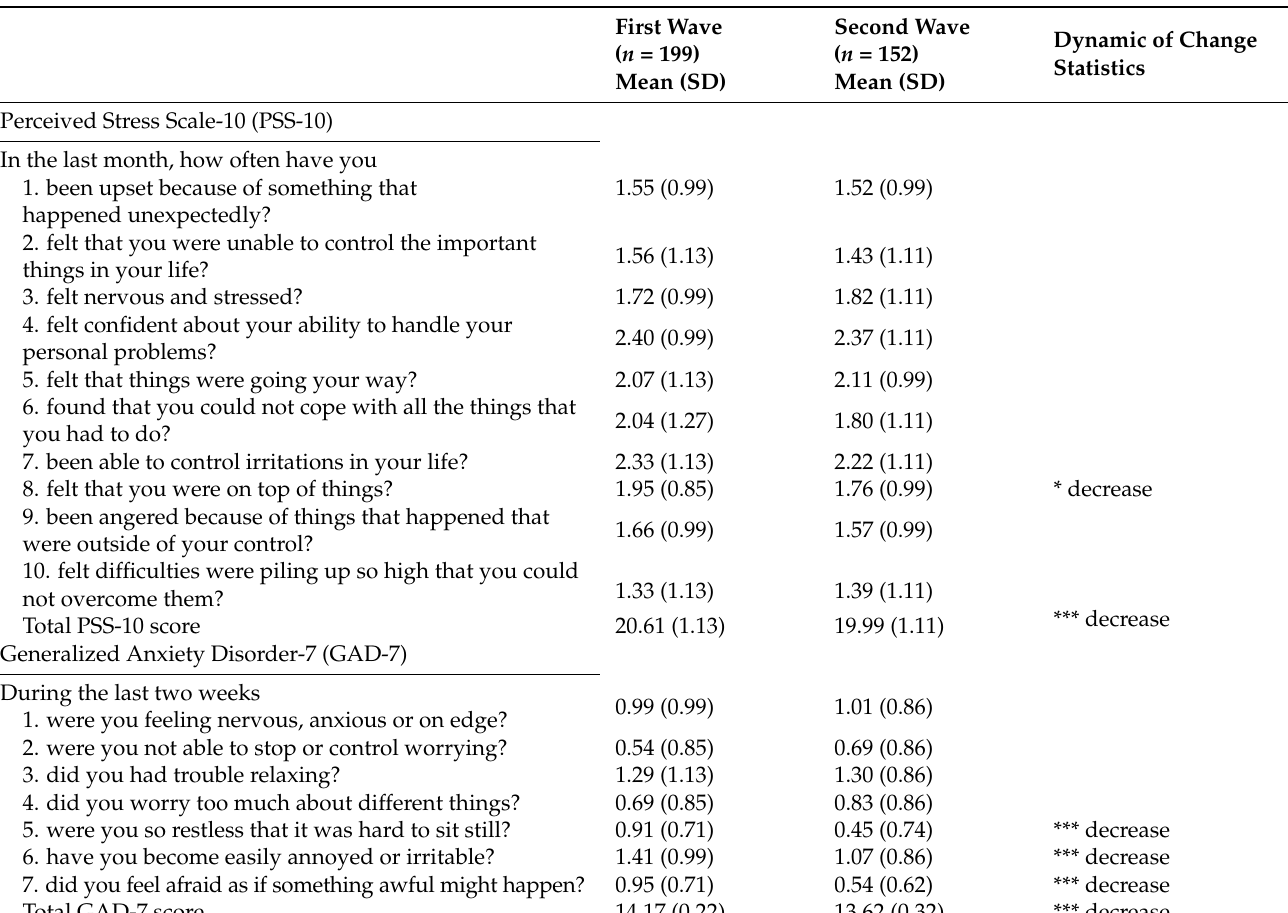
Table 4. Perceived stress and general anxiety disorders.